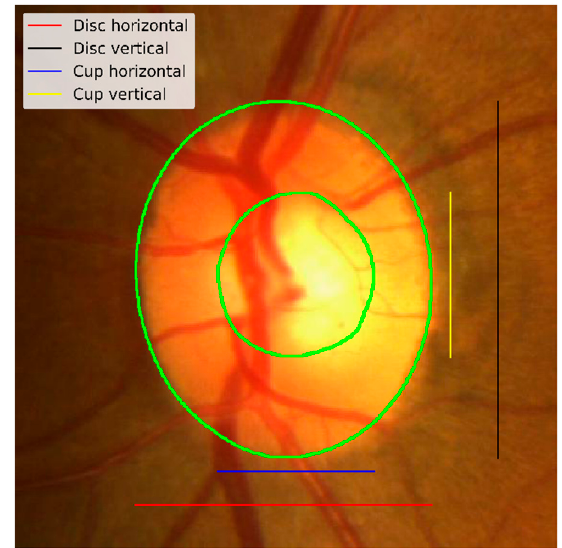
Figure 5. Vertical / horizontal cup and disc Figure 5. Vertical/horizontal cup and disc measurements . Figure 5. Vertical/horizontal cup and disc measurements .